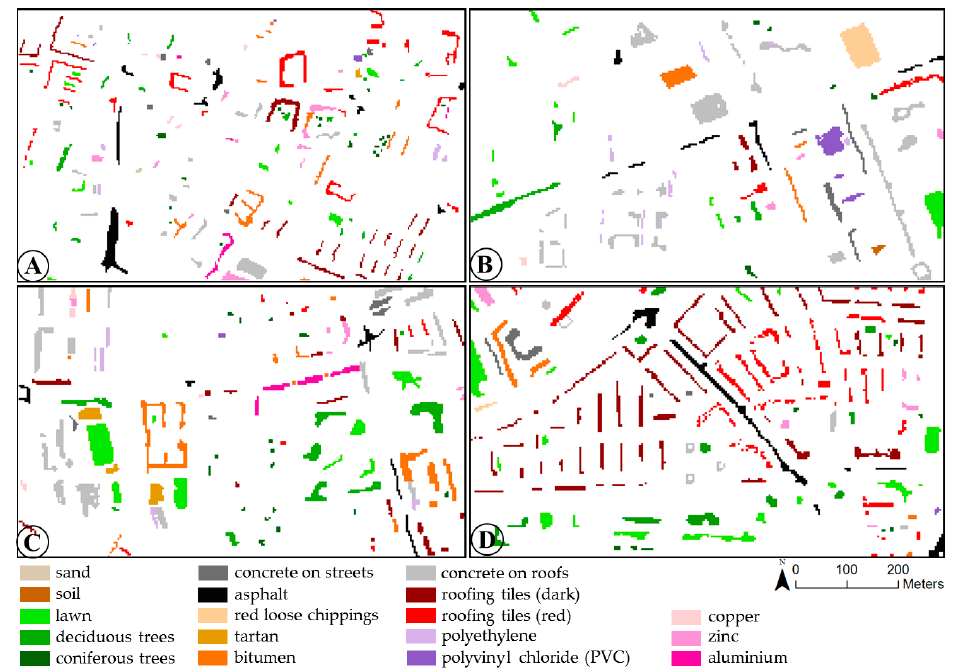
Figure 3. Validation data for test sites ( A – D ) in Munich, Germany.